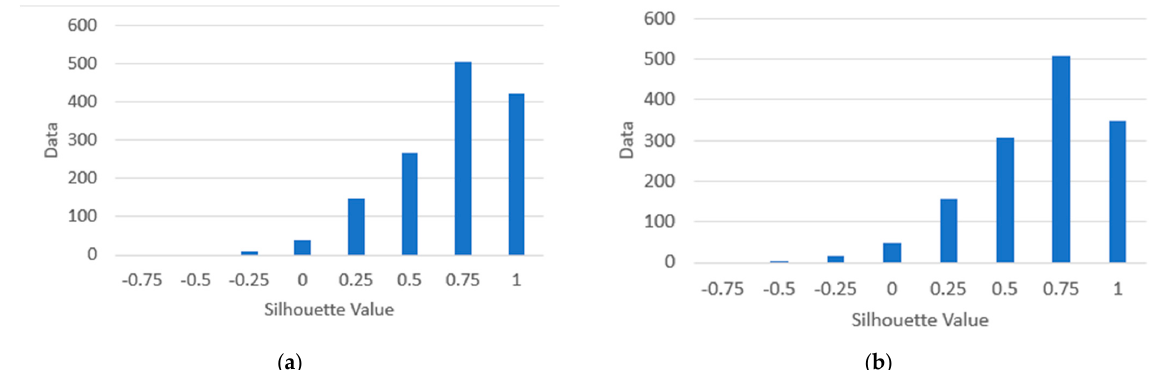
Figure 4. ( a ) Evaluation result of the silhouette technique when the number of vertiports is 40; ( b ) evaluation result of the silhouette technique when the number of vertiports is 100.